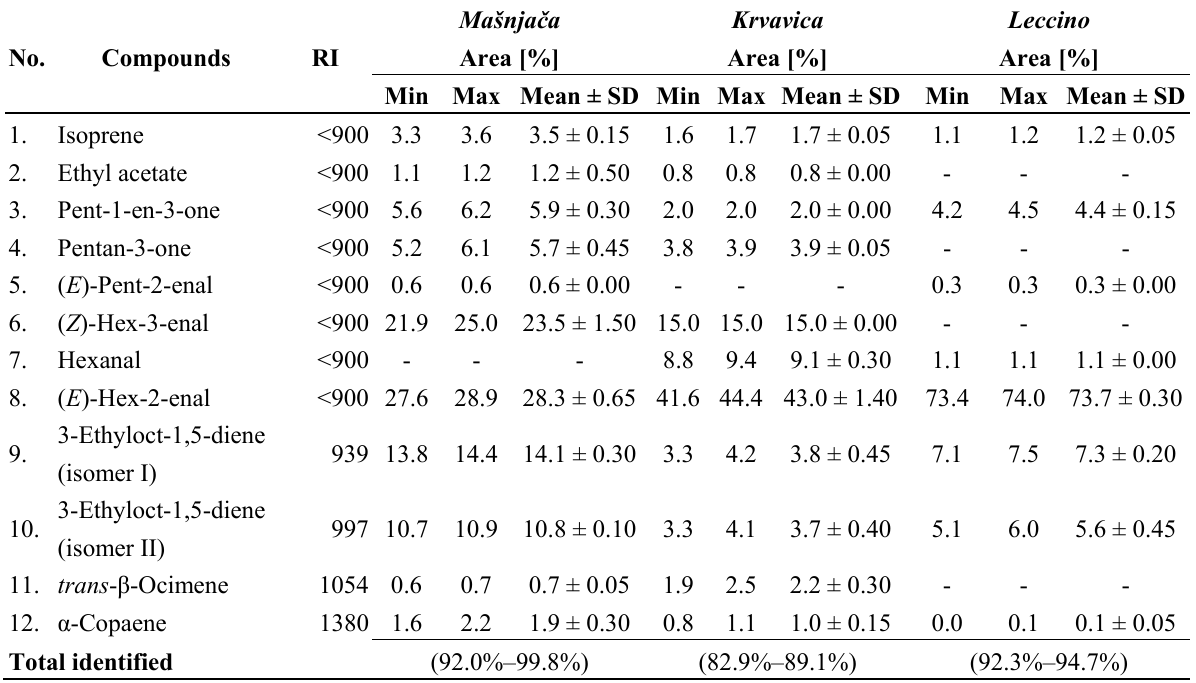
Table 2. VOCs from Krvavica , Mašnja č a and Leccino VOOs detected by